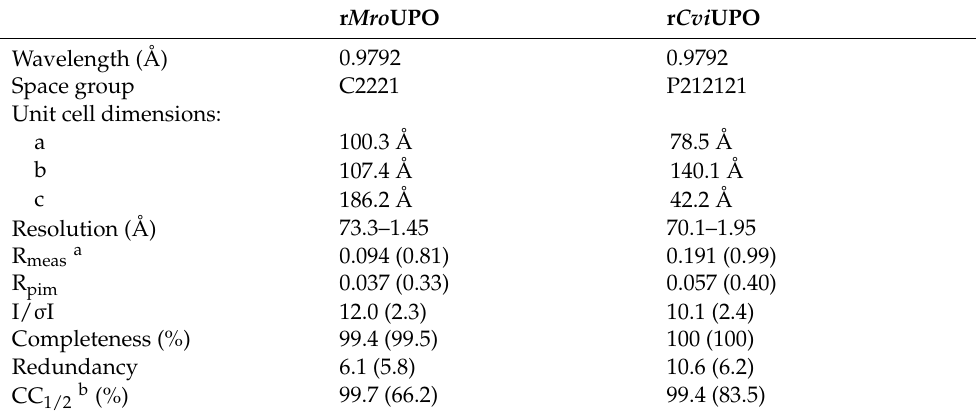
Table 1. X-ray crystallographic data collection